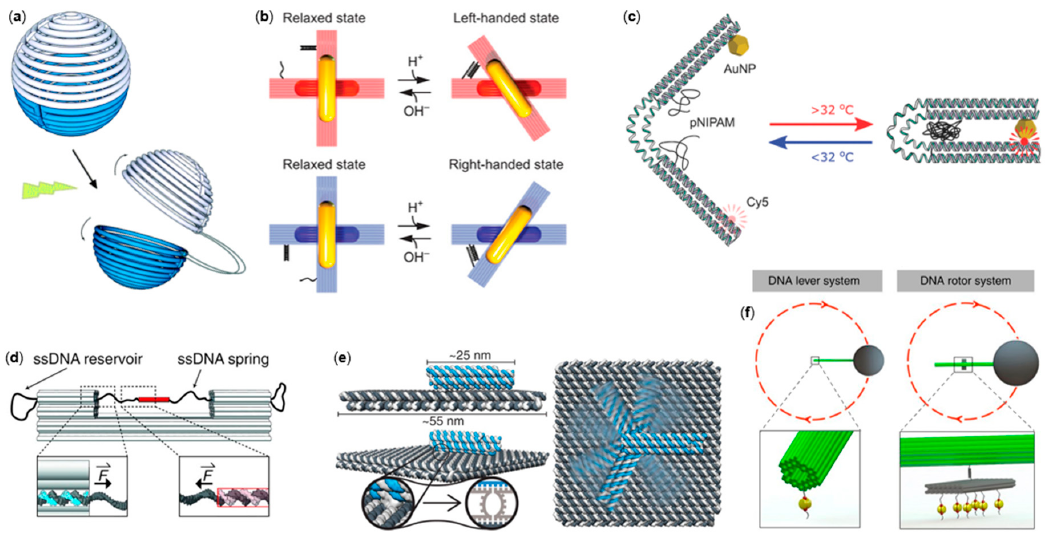
Figure 3. DNA origami movement using stimuli. ( a ) A spherical DNA origami container that can be opened by light [100]; ( b ) Reconfigurable chiral plasmonic metamolecules [103]; ( c ) A thermoresponsive